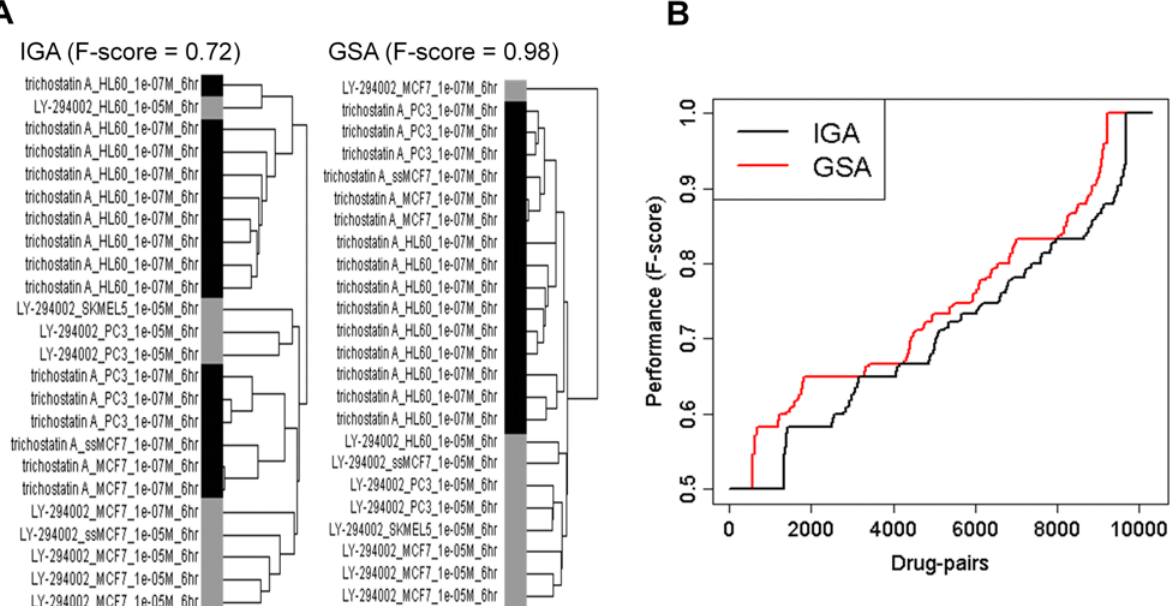
Fig 4. Separation of two drugs among all instances involving the drug pair is done better using gene-set/tag enrichment scores. Quality of separation is determined by F-scores for hierarchical clusters, constructed using tag enrichment scores and log-ratios for gene expressions, respectively, of all instances involving the drug pair. (A) Two clusters for the drug-pair valproic acid and trichostatin A; cluster based on gene expression, cluster on left, and on tag, cluster on right. Two-color bar indicates drug classification. (B) Ranking by F-scores of ~20,000 drug-pairs from the CMap development batch on HG-U133A platform involving 407 drugs and 674 chips; black, gene expression and red, tag.